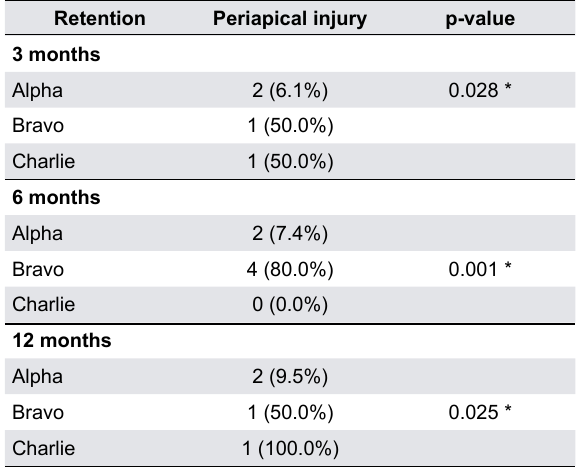
Table 6- Characteristics of coronal restorations over time in primary teeth endodontically treated with manual and rotary